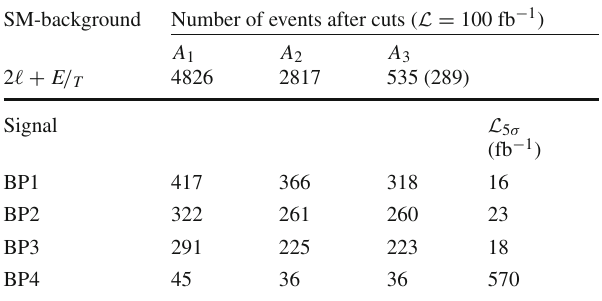
Table 6 The cut-flow for signal and backgrounds for 2 (cid:10) + E / T channel along with the required integrated luminosity required for 5 σ signifi- cance for benchmarks BP1, BP2, BP3 and BP4 at 1 TeV ILC. The bracketed term in the A 3 cut denotes the surviving number of events for M eff < 350 GeV cut for the background